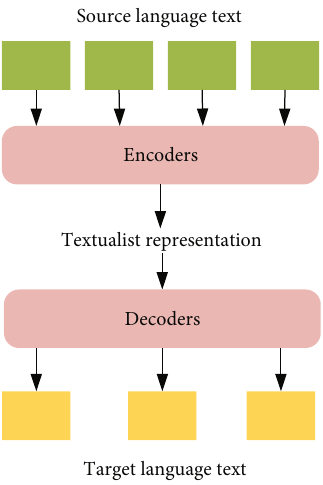
Figure 1: A machine translation model with a simple “ encoder- decoder ”